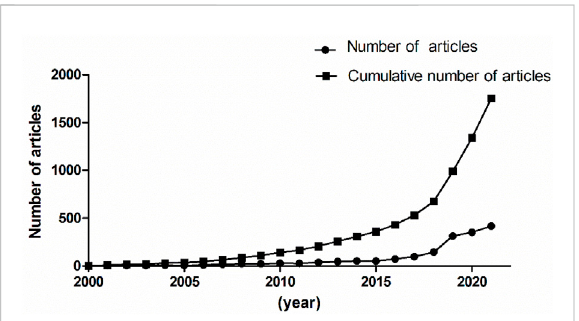
FIGURE 1 Numberofpublishedarticles aboutdeeplearningapplication in genetics research from 2000 to